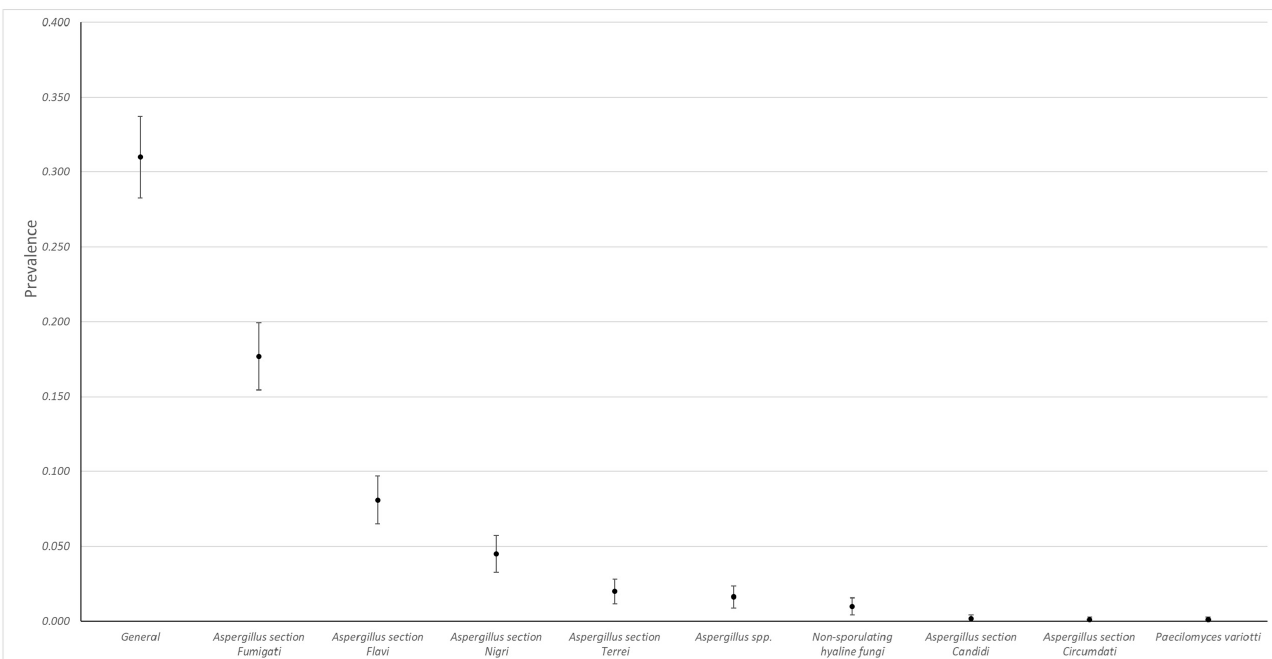
Figure 1. Observed prevalences (95% CI) of fungi isolated in chicken lungs ( Gallus gallus ) ranging from 2008 to 2021 in the Mycology Laboratory, School of Veterinary Medicine, Universidad Nacional, Heredia, Costa Rica.